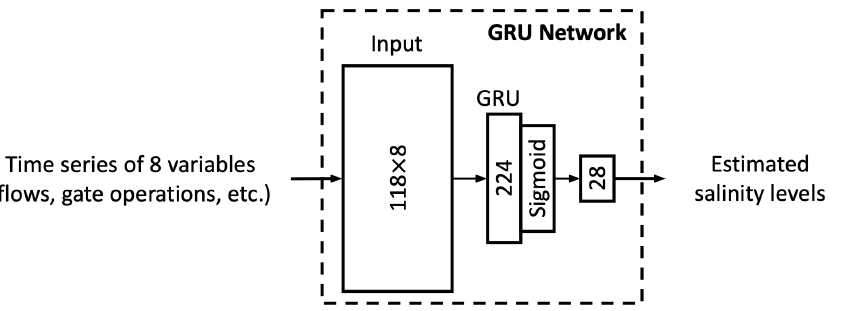
Figure 4. Architecture of the proposed MTL GRU Network. Numbers in input layer blocks represent the input shape while numbers insides subsequent layers represent the numbers of units/neurons of the layer.